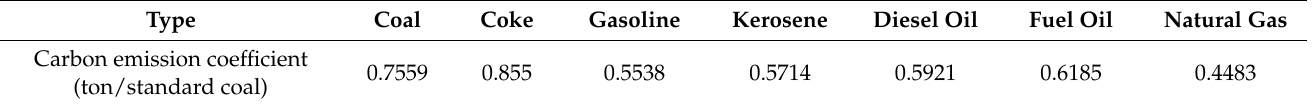
Table 1. Carbon emission coefficient.